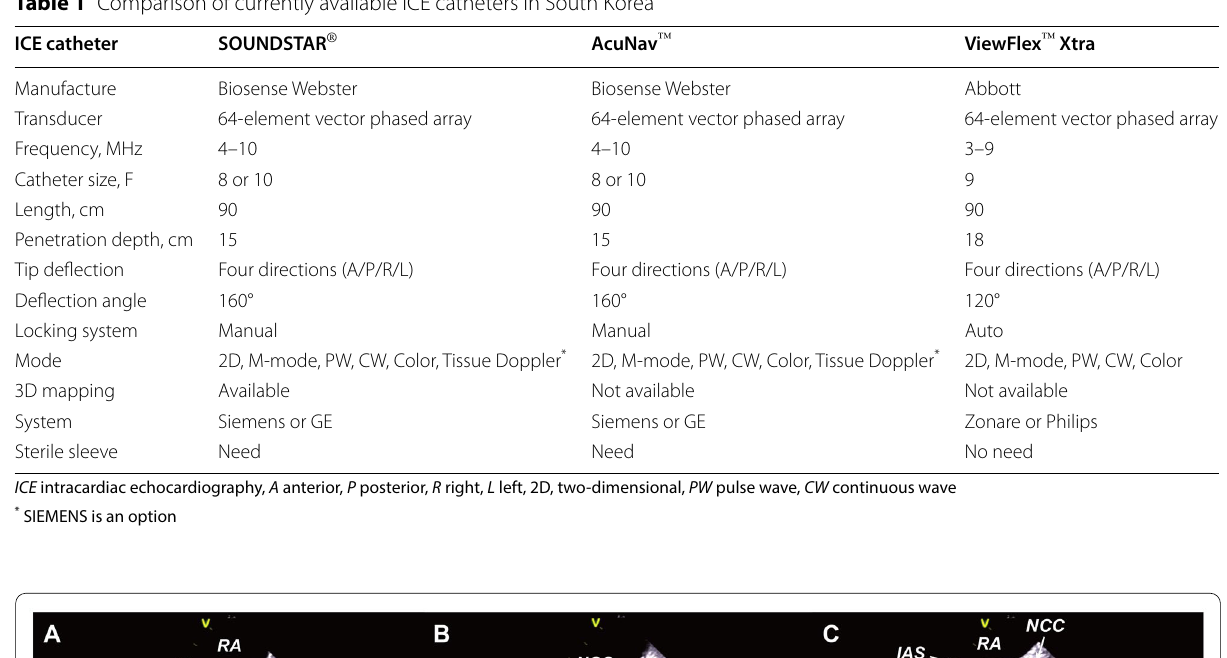
Table 1 Comparison of currently available ICE catheters in South Korea